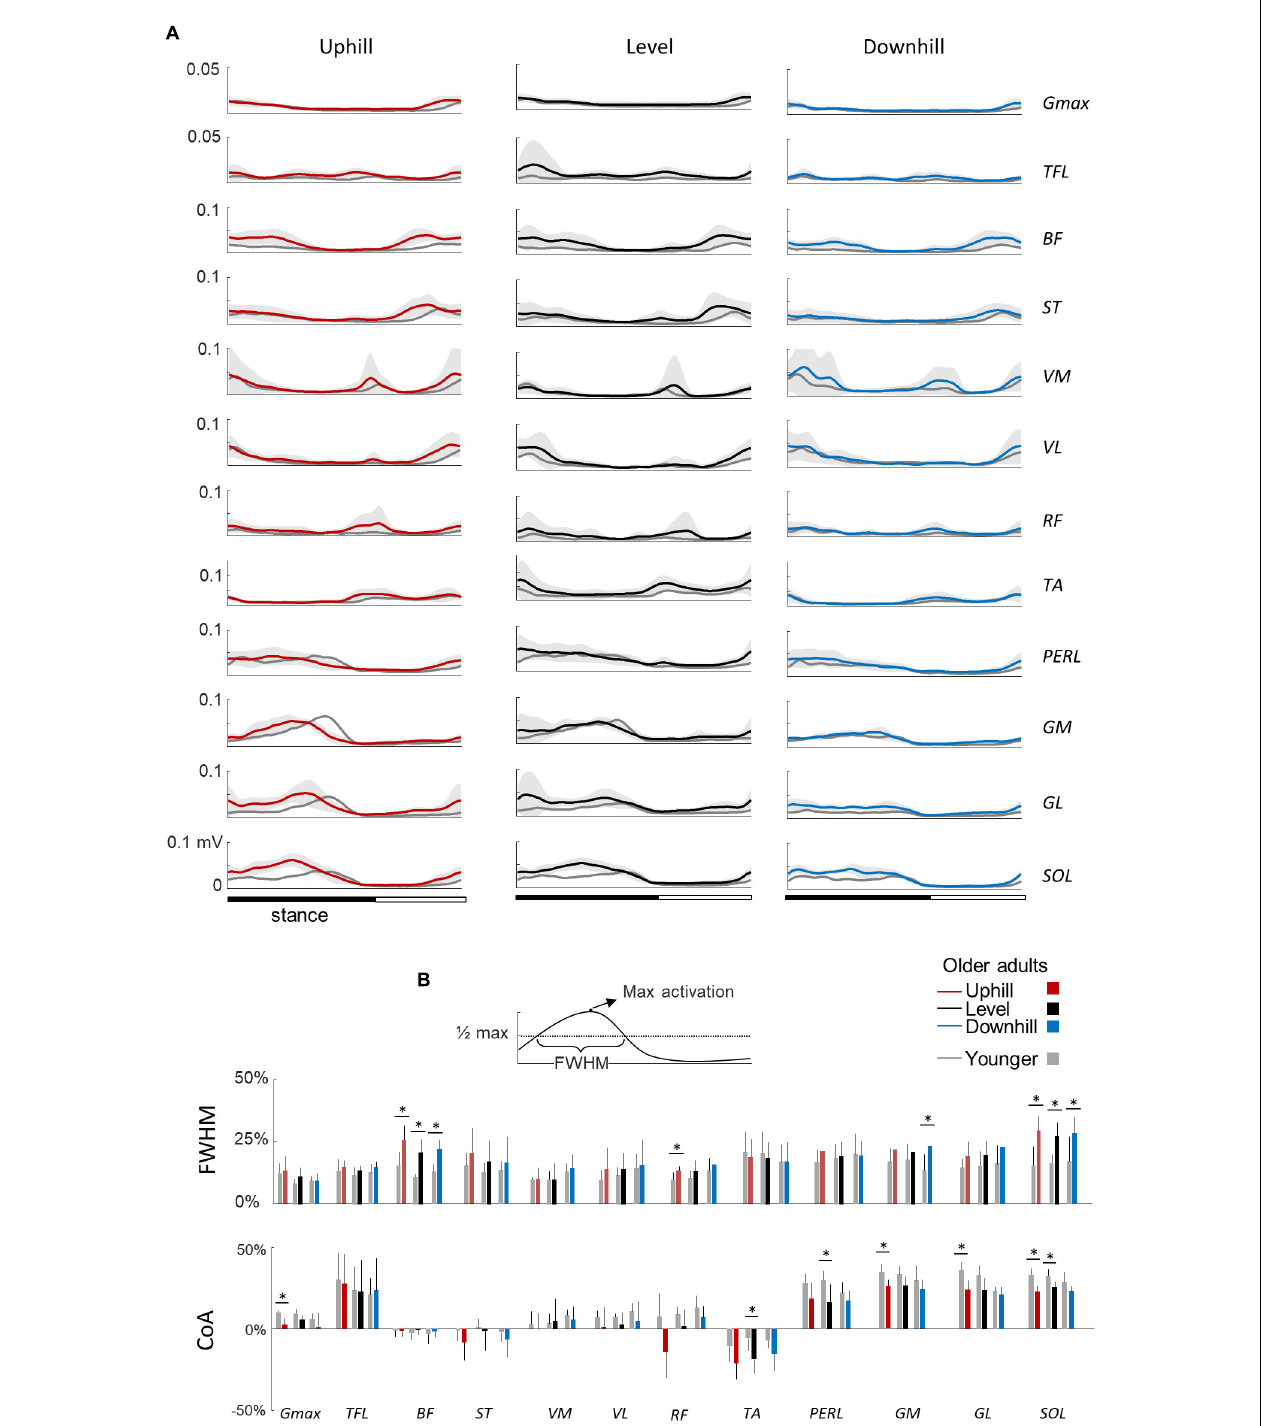
FIGURE 4 | Ensemble-averaged electromyogram (EMG) patterns during uphill, level, and downhill walking in young and older adults. (A) Ensemble-averaged EMG patterns over one stride in uphill (red), level (black), and downhill (blue) walking. Gmax , gluteus maximus; TFL , tensor fascia latae; VM , vastus medialis; VL , vastus lateralis; RF , rectus femoris; BF , biceps femoris; ST , semitendinous; TA , tibialis anterior; MG , gastrocnemius medialis; LG , lateral gastrocnemius; SOL , soleus; PERL , peroneus longus. The curves presented here are the average of the mean-curves of all the young (gray lines) and elderly (colored lines) adults. The gray zone represents ± 1 SD for the older adults. (B) Full Width Half Maximum (FWHM) and center of activity (CoA) of the 12 lower-limb muscles at each walking condition. The bars represent the grand mean of all the young (gray) and the elderly (colored) adults. Thin lines represent one standard deviation. The * indicates a significant effect of age (Student t -test, p <